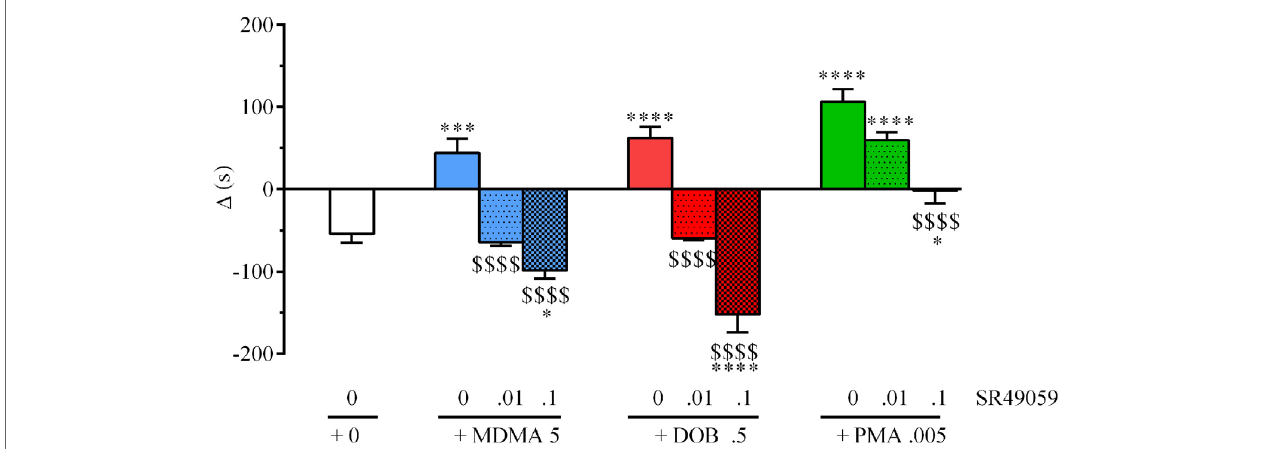
FigUre 4 | SR49050 dose-dependently antagonizes 3,4-methylenedioxymethamphetamine (MDMA)-, 2,5-dimethoxy-4-bromo-amphetamine hydrobromide (DOB)-, and para -methoxyamphetamine (PMA)-induced social preference in zebra fish. Mean values ± SEM of the differences in the time spent (s) in the compartment near to the nacre picture and the time spent near to the WT picture ( Δ ). The combination of SR49059 (ng/kg) or vehicle and each drug (mg/kg) was given intramuscularly (IM) immediately before the test. n = 10 fish per group. * p < 0.05, *** p < 0.001, **** p < 0.0001 vs. saline (0 + 0); $$$$ p < 0.001 vs. the corresponding drug alone (Tukey’s